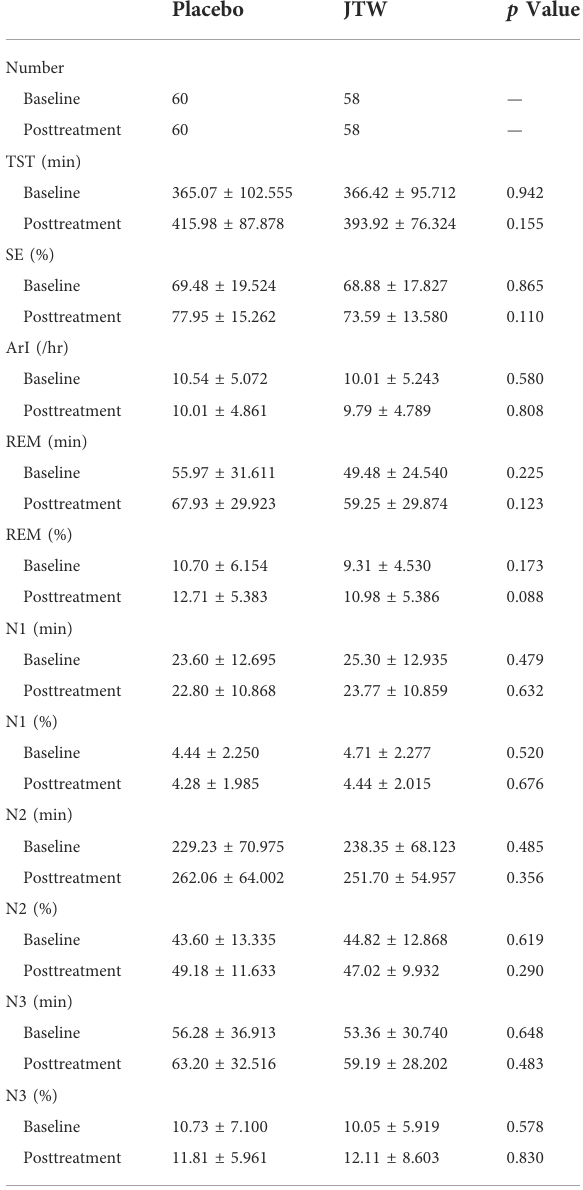
TABLE 3 Analysis and comparison of PSG in the participants at baseline and posttreatment between the JTW and placebo